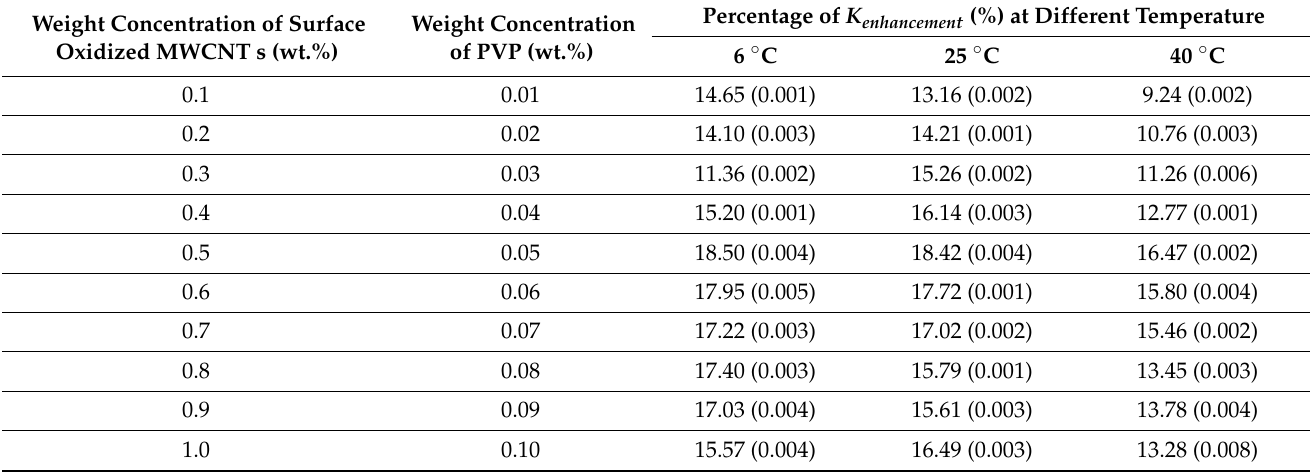
Table 8. Thermal conductivity enhancement of surface oxidized MWCNTs nanofluid with PVP. Percentage of K enhancement (%) at Different Weight Concentration of Surface Weight Concentration Oxidized MWCNT s (wt.%) of PVP (wt.%)